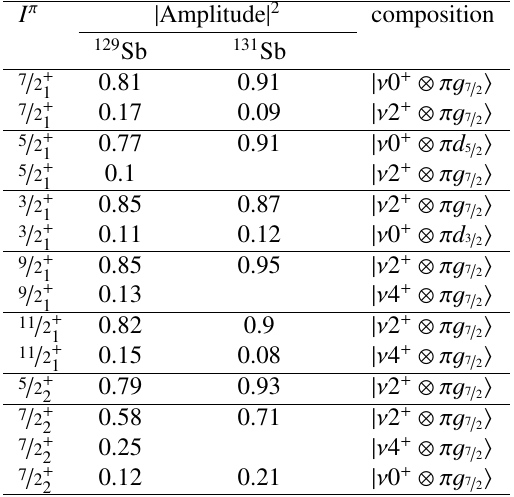
Table 3. Dominant wavefunction components for Sb isotopes.